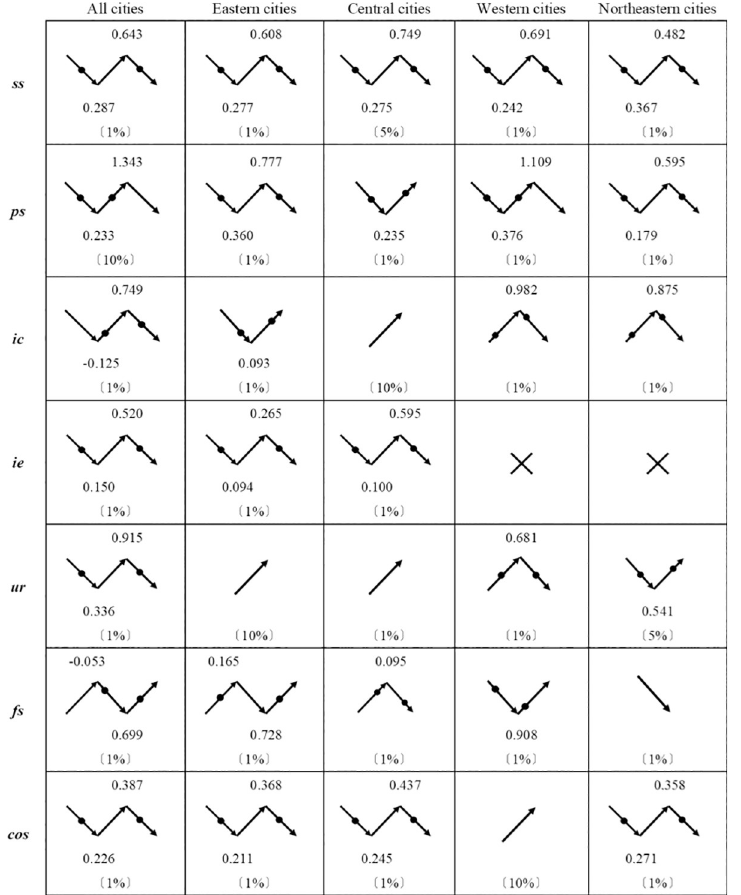
Fig 7. Trends of structure on economic growth according to empirical